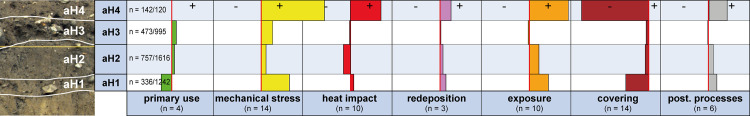
The taphonomic processes and their impact on the different archaeological horizons aH1-aH4 (pottery and animal bones combined).Bars to the left (-) show a slight/rare manifestation, whilst bars to the right (+) signify a strong/frequent manifestation of the process.